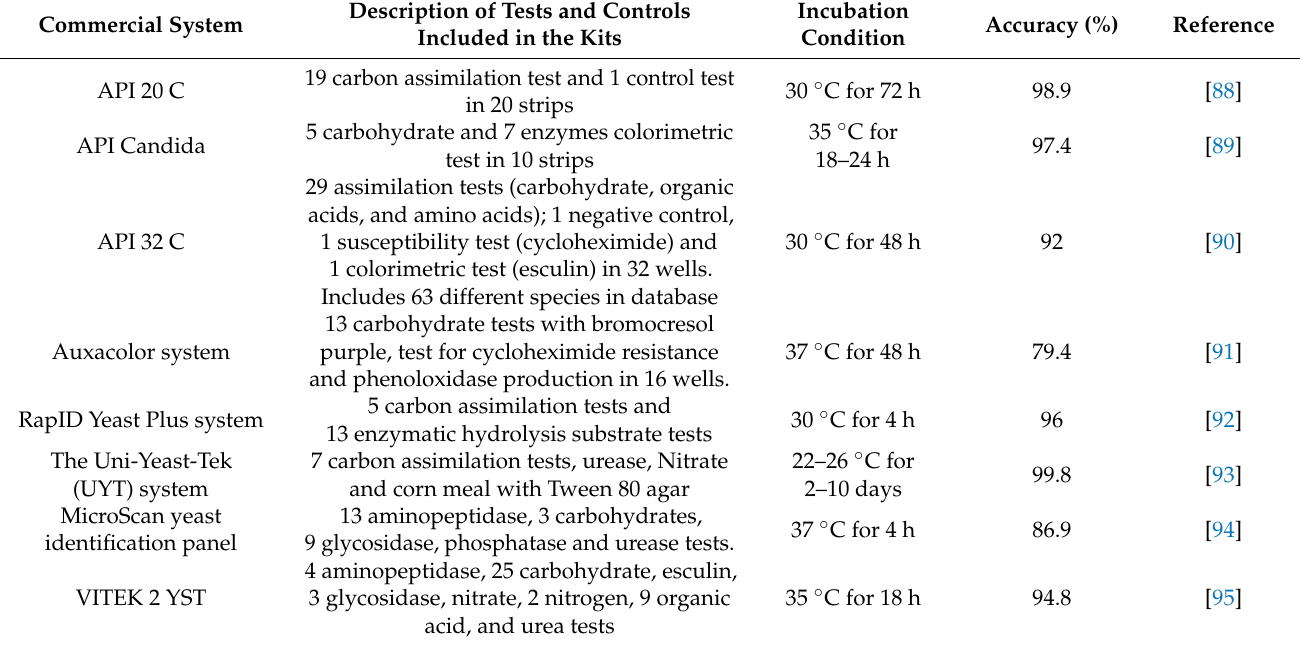
Table 8. Summary of tests and accuracy of common commercial yeast identification